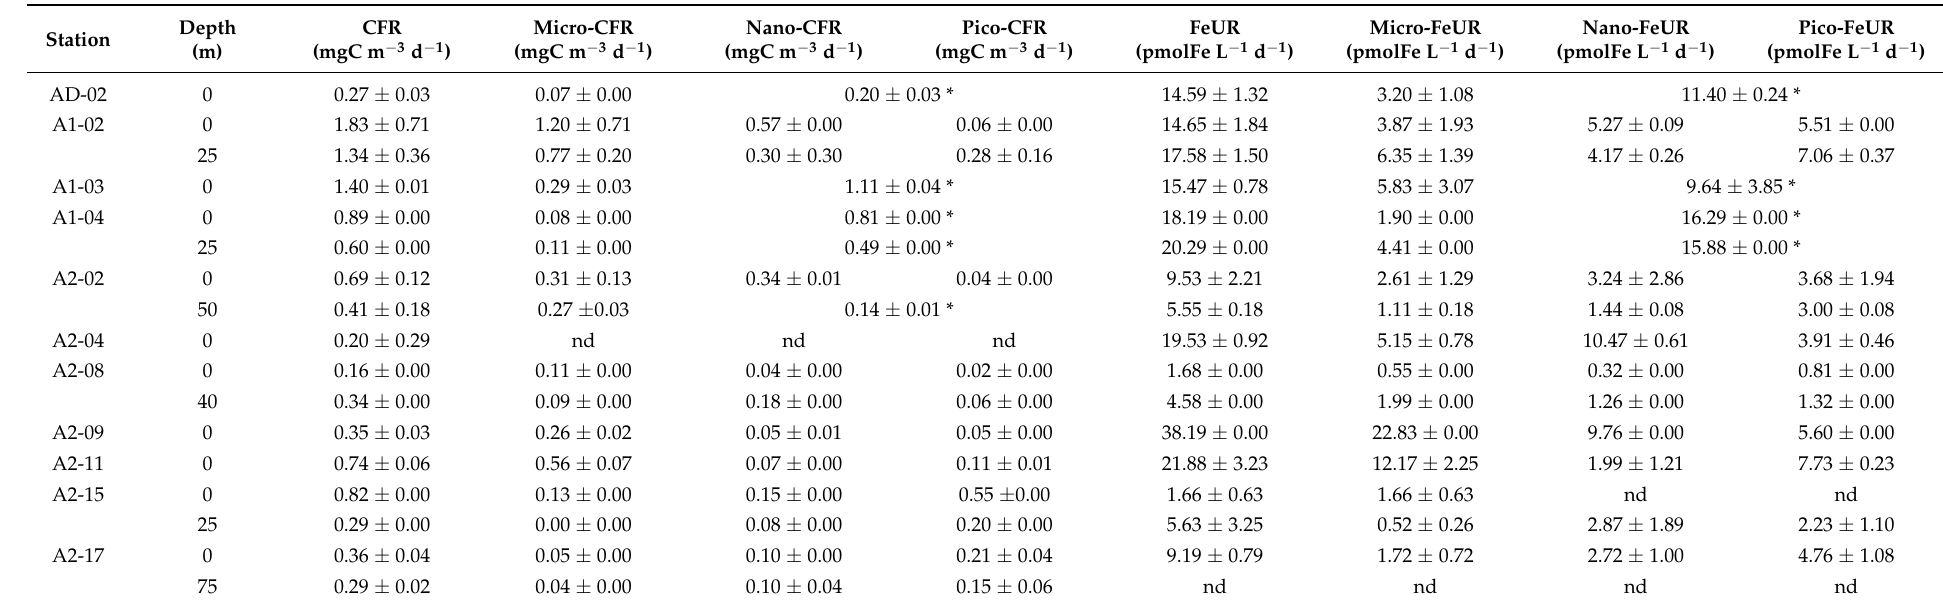
Table 1. Data on the CFR and FeUR values and their size-fractionated distributions in the Amundsen